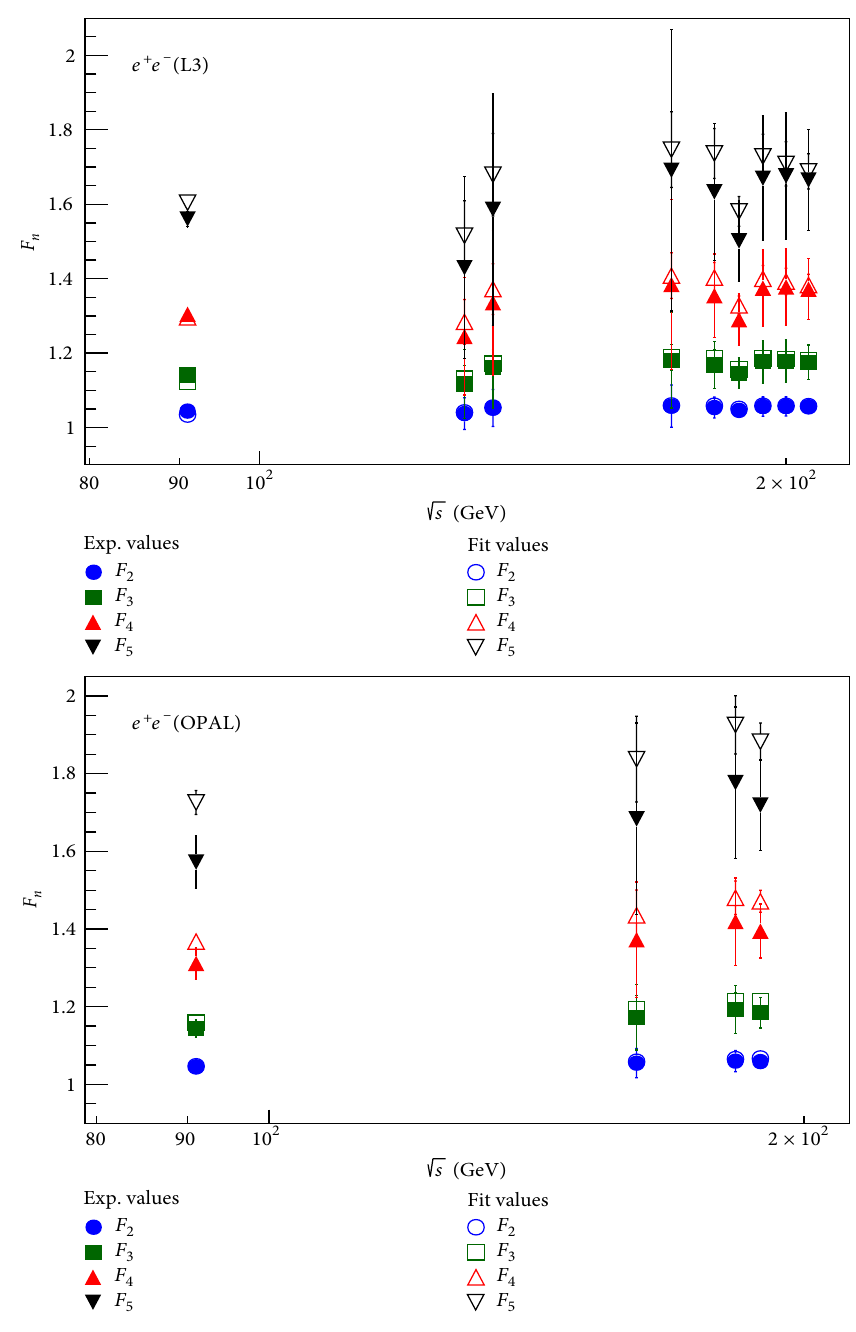
+ − collisions recorded by the L3 and OPAL experiments 𝑒 𝑒